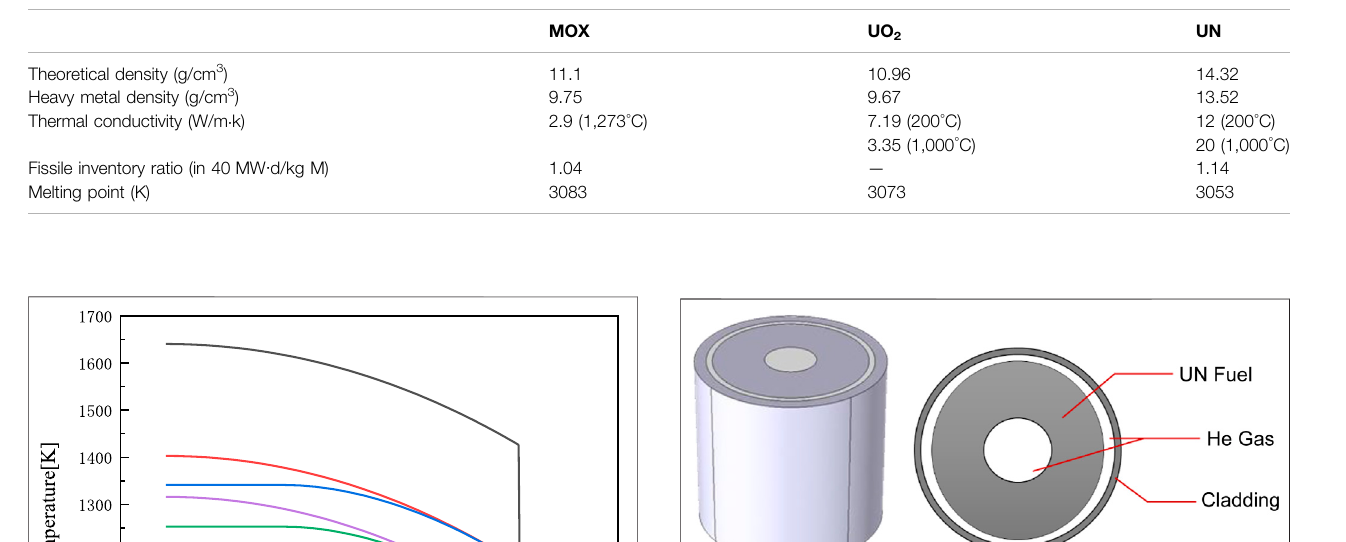
TABLE 1 | Comparison of basic performance of MOX, UO 2 and UN (Arai, 2012; Bo et al., 2013).